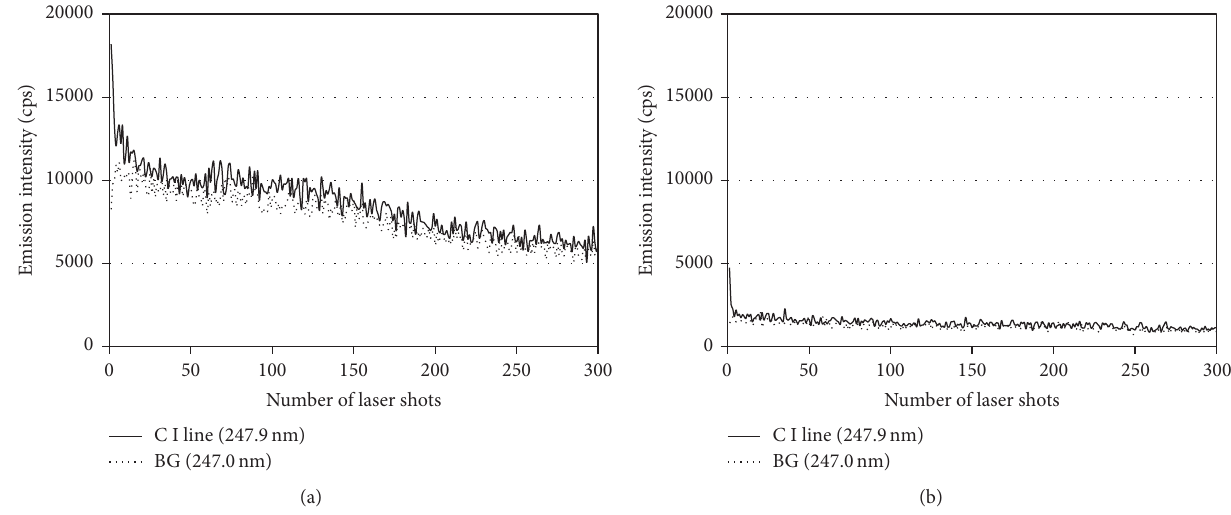
Figure 5: Emission signals from both C (247.9 nm) and background (247.0nm) observed for Zn under (a) Ar and (b) He chamber gas conditions as a function of laser shots.